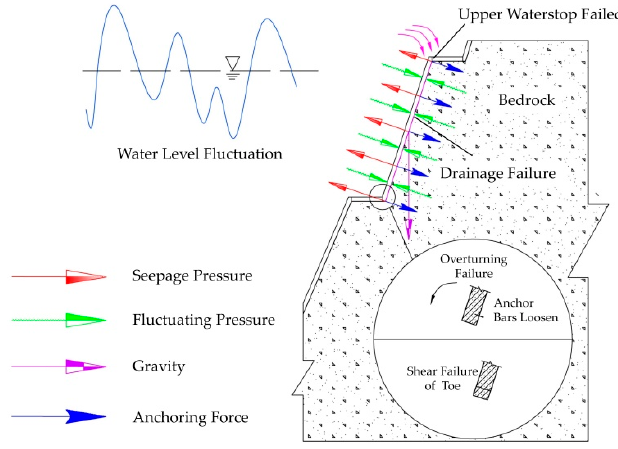
Figure 11. Schematic diagram for the stress state of drainage failure slope plate.